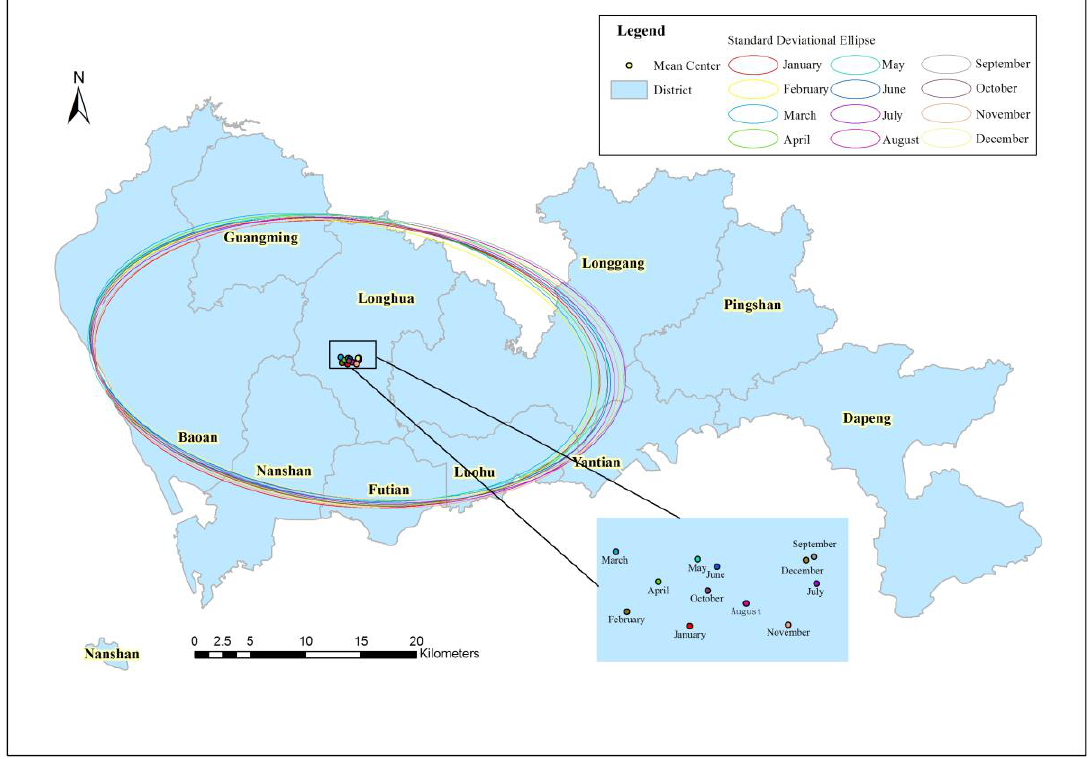
Figure 3. Spatio-temporal distribution of trauma in Shenzhen.